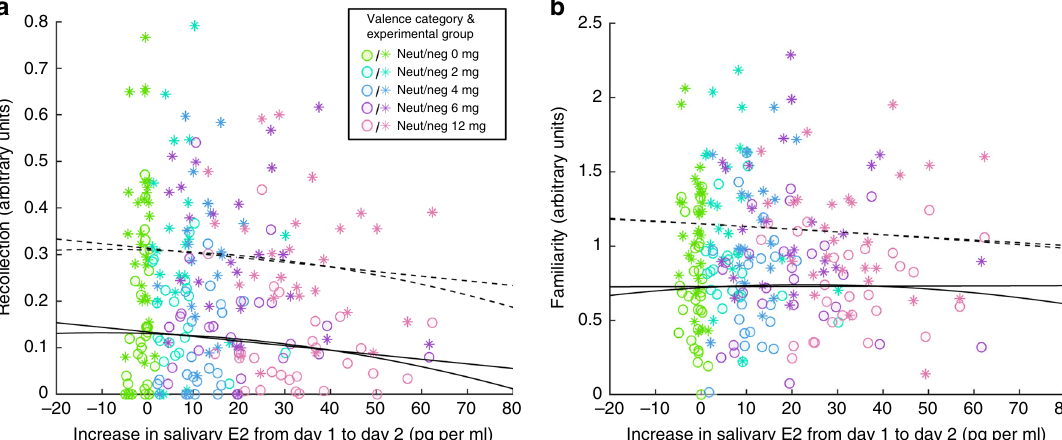
Fig. 3 Regression between memory and E2 increases in salivary 17-beta-estradiol (E2; N = 123). Neither hippocampus-dependent memory (recollection; a ) nor hippocampus-independent memory (familiarity; b ) shows signi fi cant relationships to salivary Day 1 to Day 2 E2 increase. Colors represent experimental groups (all p corr ’ s > .2)